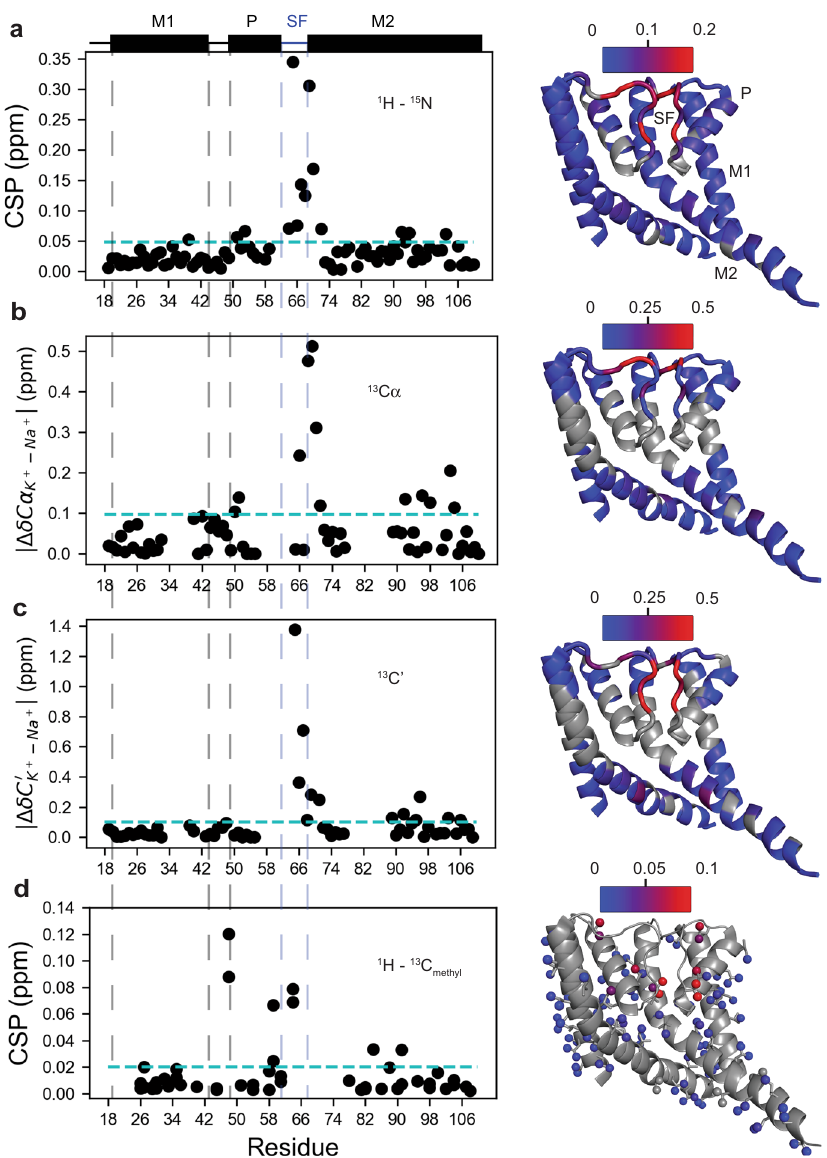
Fig. 3 SF and hinge residues display ion-dependent chemical shifts. Backbone amide ( a ) and ILV methyl ( d ) chemical shift perturbations (CSPs) along with 13 C ’ ( c ) and 13 C α ( b ) chemical shift differences ( Δδ ) were calculated for NaK in 100 mM K + vs 600 mM Na + . CSPs (calculated as described in Methods) and Δδ values for residues assigned in both conditions are plotted against residue number. In each plot, the cyan line indicates 1.5 σ above the 10% trimmed mean. CSPs and Δδ values are also plotted on the NaK structure (3E8H [10.2210/pdb3E8H/pdb], 2 adjacent of 4 subunits shown for clarity). Color scale bars are shown for each plot. 1 H – 15 N CSPs, 13 C ’ Δδ , and 13 C α Δδ values are plotted on the backbone and residues for which data are not available are colored gray. 1 H – 13 C methyl CSPs are plotted on the side-chains and the backbone is shown in gray. Secondary structure elements are indicated on the plots and labeled on the structure in panel a